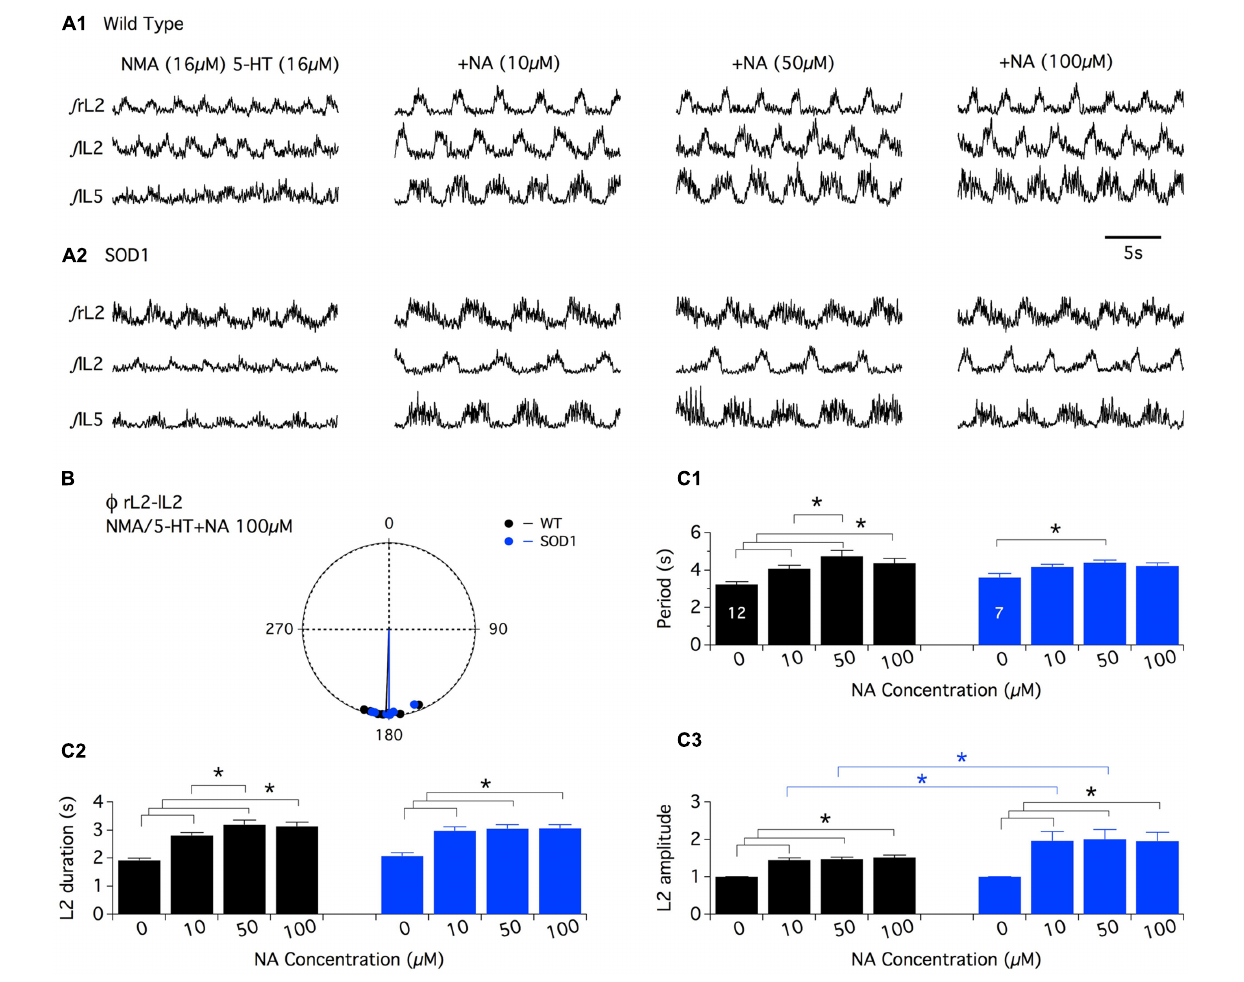
FIGURE 3 | Neuromodulatory actions of noradrenaline on (blue dots and line, n = 7) spinal cords in the presence of 100 μ m NA. NMA + 5-HT-induced fictive locomotion in SOD1 and age-matched (C) Plots of the period (C1) , L2 burst duration (C2) and amplitude (C3) in the (cid:2) absence or presence of NA bath-applied at increasing concentrations onWT control mice. (A) Representative integrated ( ) extracellular recordings from (black bars) and SOD1 (blue bars) spinal cord preparations. Note the the right, left L2 and left L5 ventral roots (rL2, lL2, and lL5) in the presence of significant difference in L2 motor burst modulation betweenWT and SOD1 NMA + 5-HT (16 μ m each) alone or with noradrenaline (NA; 10, 50, or 100 μ m) mice. Asterisks indicate positive significance levels and the numbers in inWT animals (A1) and SOD1 mice (A2) . (B) Polar graph of the rL2–lL2 phase histogram bars refer to the number of spinal cord preparations ( (cid:2) ) relationships computed inWT (black dots and line, n = 12) and SOD1